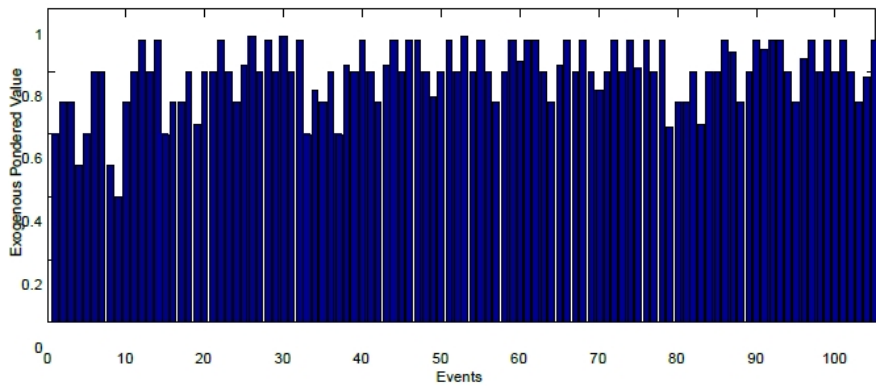
Figure 10. Maximum allowed exogenous pondered value for each maintenance tasks.